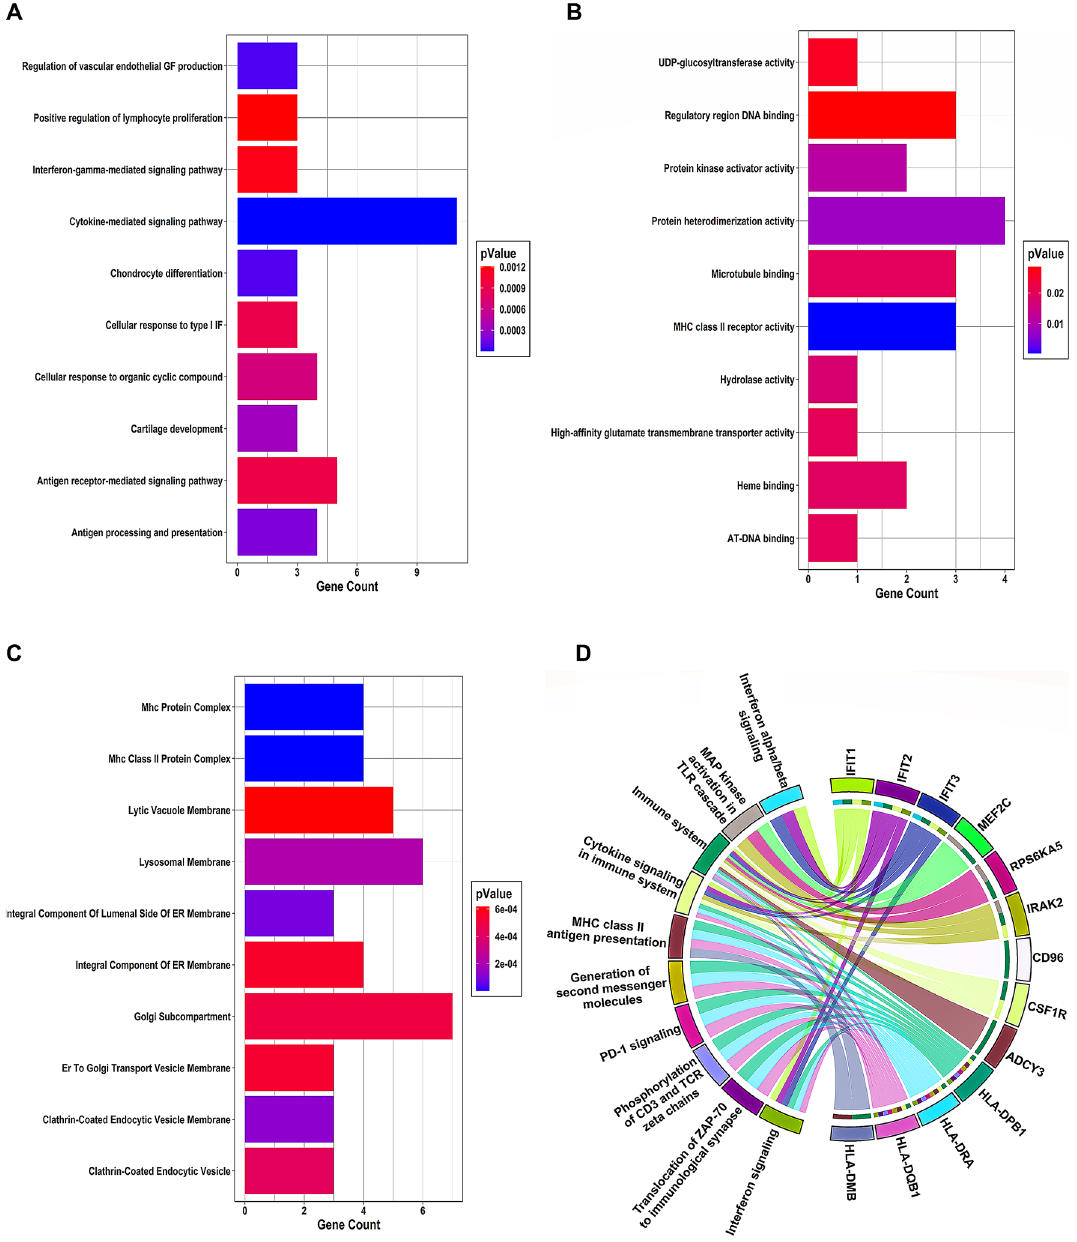
Figure 3. (A) Barplot offering significant GO-BP terms (on the y-axis) as bars concerning gene count (on the x-axis). The color of the bars varies following the p-value. (B) Barplot shows significant GO-MF terms (on the y-axis) as bars concerning gene count (on the x-axis). The color of the bars varies following the p-value. (C) Barplot showing the connection of significant GO-CC terms (on the y-axis) with corresponding gene count (on the x-axis). The bar color varies following the p-value. (D) Chord plot exhibiting the link of 13 DEGs (right semicircle) with ten significant pathways (left semicircle) via undirected colored